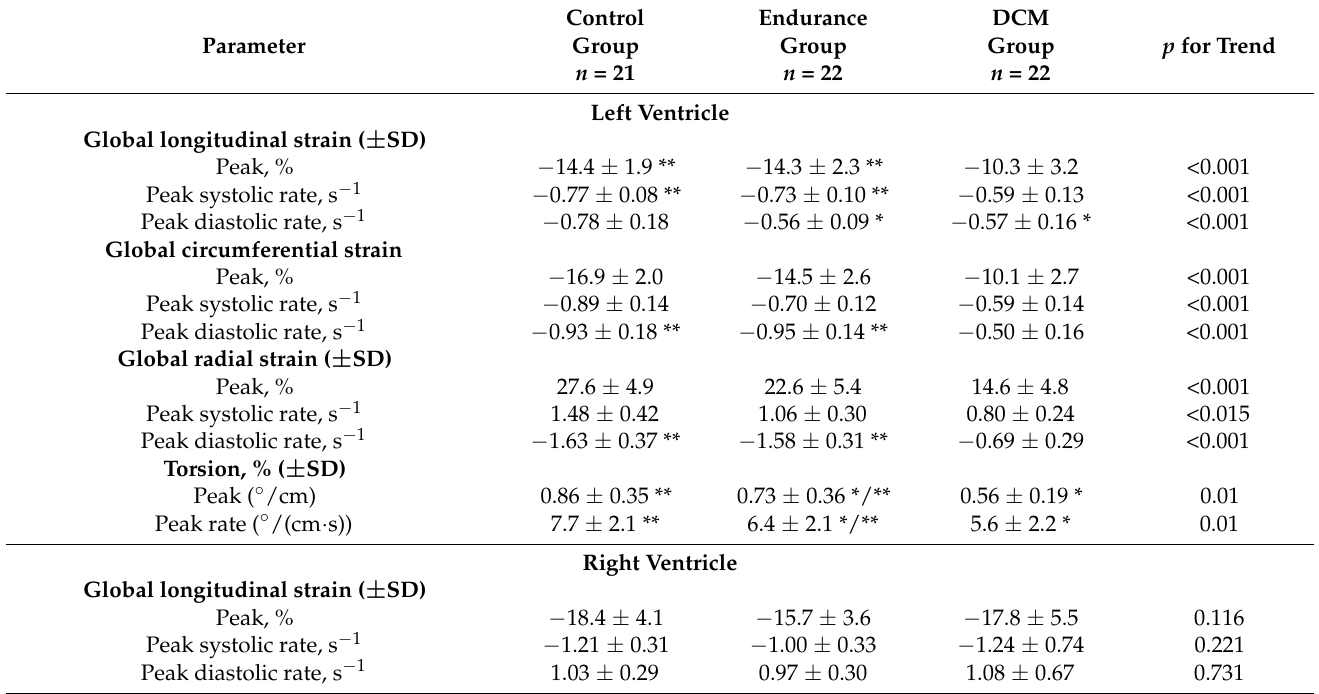
Table 2. Deformation parameters of the left and right ventricles in the studied